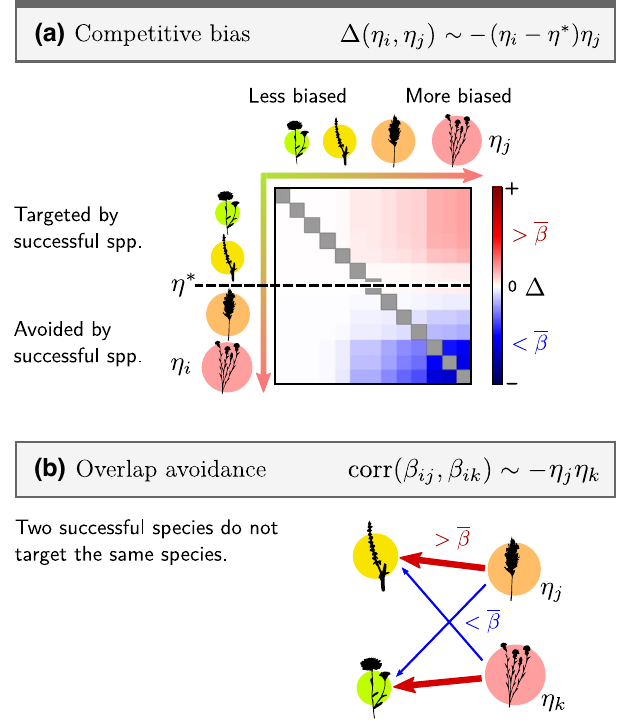
FIG. 3. The diffuse clique structure is characterized by two statistical patterns in how successful species compete. Any typical interaction network drawn from the posterior distribution P ð β j ⃗ η Þ (see Fig. 2) will have similar statistical features. (a) Trend j ⃗ η (cid:2) of competition strength Eq. (4). If all in the expectation E ½ β ij ¯ β species competed with equal strength , we would expect any ¼ η (cid:3) [Eq. (3)]. given species i to achieve the relative yield η i Given how much η differs from this baseline, we can infer how i ¯ β interactions most likely deviate from . We show this deviation Δ ð η Þ for simulated data, in matrix form: each element shows ; η i j the bias in the interaction effect of species j (column) on species i (row). Left to right: An unsuccessful species (low η ) competes j indiscriminately against others (white, Δ ¼ 0 ), whereas a suc- cessful species (high η ) is a biased competitor. Top to bottom: j < η (cid:3) experience stronger competition from Species with η i > η (cid:3) successful species (red, Δ > 0 ), whereas species with η i experience weaker competition from them (blue, Δ < 0 ). To- gether, these biases indicate the existence of a “ clique ” of species that compete less against each other, and more against all others, thus achieving higher relative yield than the baseline η (cid:3) . (b) Cor- relation structure (5) between columns of the interaction matrix: the effects of two successful species are anticorrelated, less likely to target the same species, whereas competition from unsuccess- ful species is